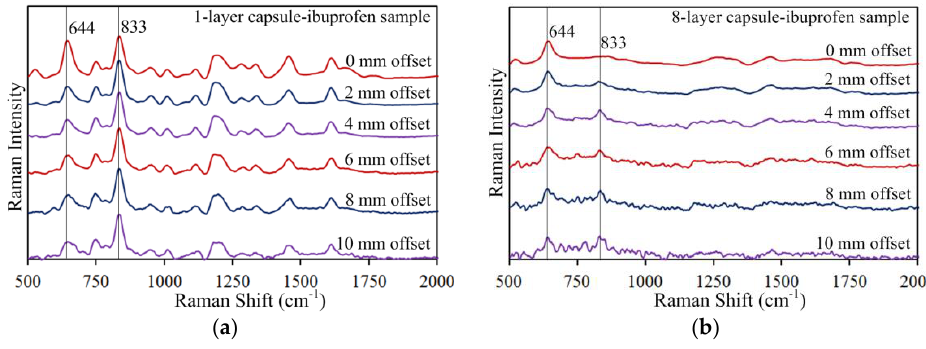
Figure 6. Spatially offset Raman spectra of ( a ) one-layer and ( b ) eight-layer capsule-ibuprofen samples.